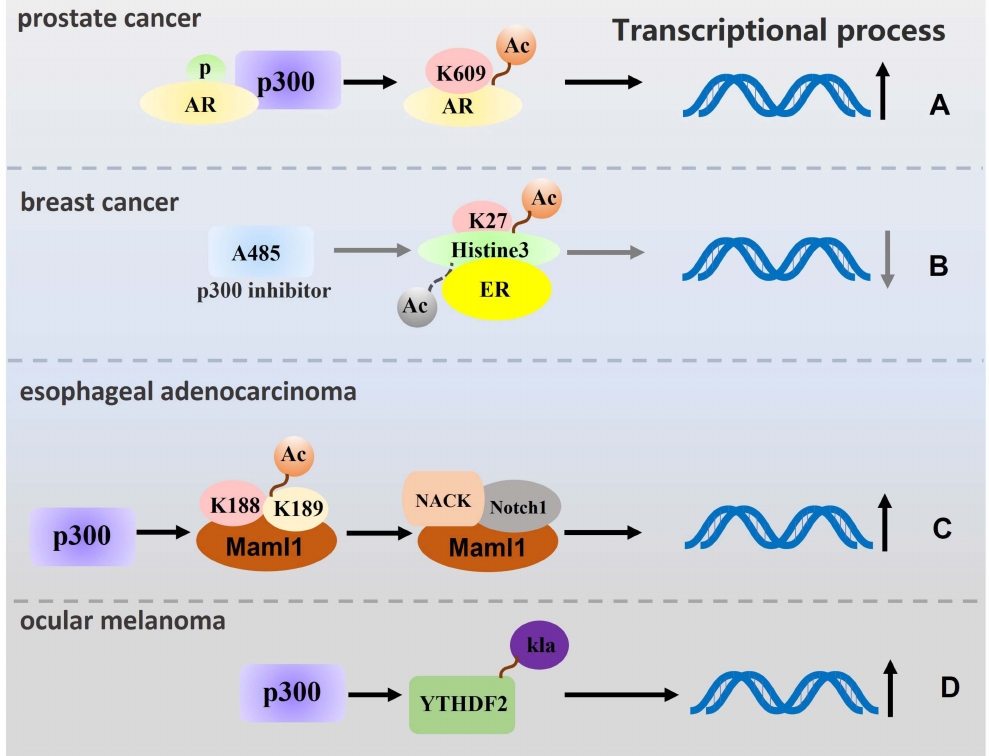
Figure 3. Schematic representation of transcription-related pathways regulated by p300. ( A ) The p300 gene recognises phosphorylated AR in prostate cancer and promotes AR acetylation in K609, thereby promoting transcription. ( B ) A485, an inhibitor of p300, can reduce the level of transcription of highly expressed genes by reducing the level of H3K27ac in particular genes (such as ER). ( C ) In esophageal adenocarcinoma, p300 acetylates K188 and K189 of Maml1, and recruits NACK to the ternary complex of Notch1, resulting in the initiation of transcription. ( D ) p300 can catalyse the lactate of YTHDF2 promoter in ocular melanoma cells and then regulate the transcription process. (Remarks: The grey arrow is the related process in which p300 inhibitors participate in regulation, and the dotted line is the process in which modification types are